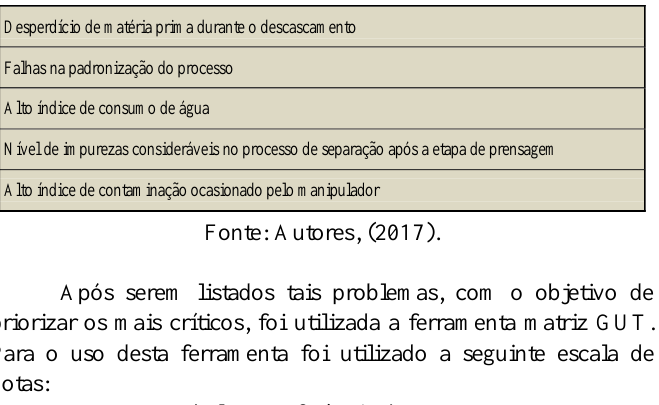
Tabela 4: Problemas encontrados.